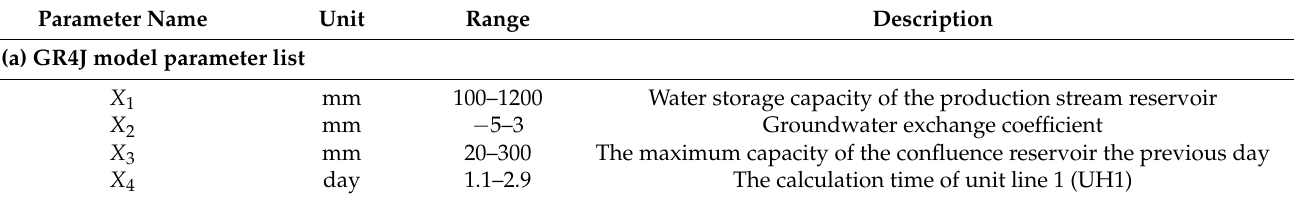
Table A1. List of the parameters of the four models: GR4J, IHACRES, Sacramento and HBV. (a) GR4J model parameter list. (b) IHACRES model parameter list. (c) Sacramento model parameter list. (d) HBV model parameter